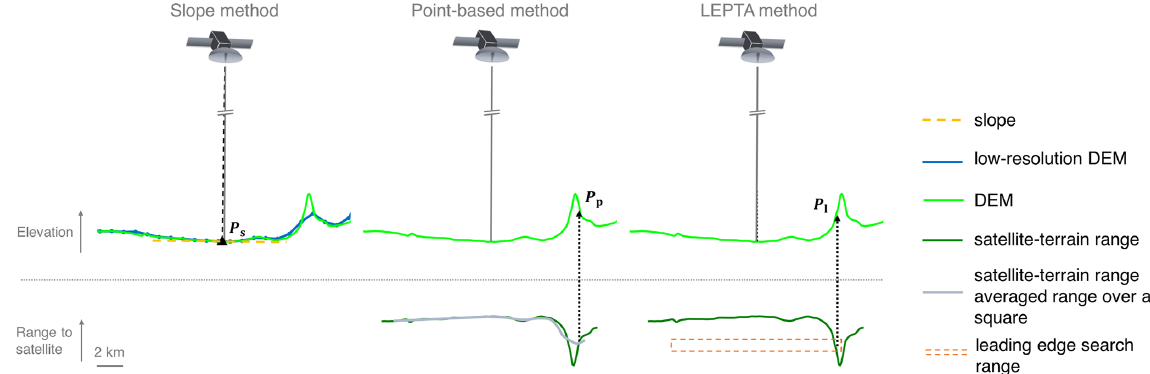
Figure 1. Conceptual illustration of different slope-induced error correction methods. The impact points estimated from the slope method, the point-based method, and LEPTA are represented by P s , P p , and P l . The slope method computes a correction based on the surface slopes obtained from a DEM, whereas the point-based method and LEPTA are based on the range between the satellite and the